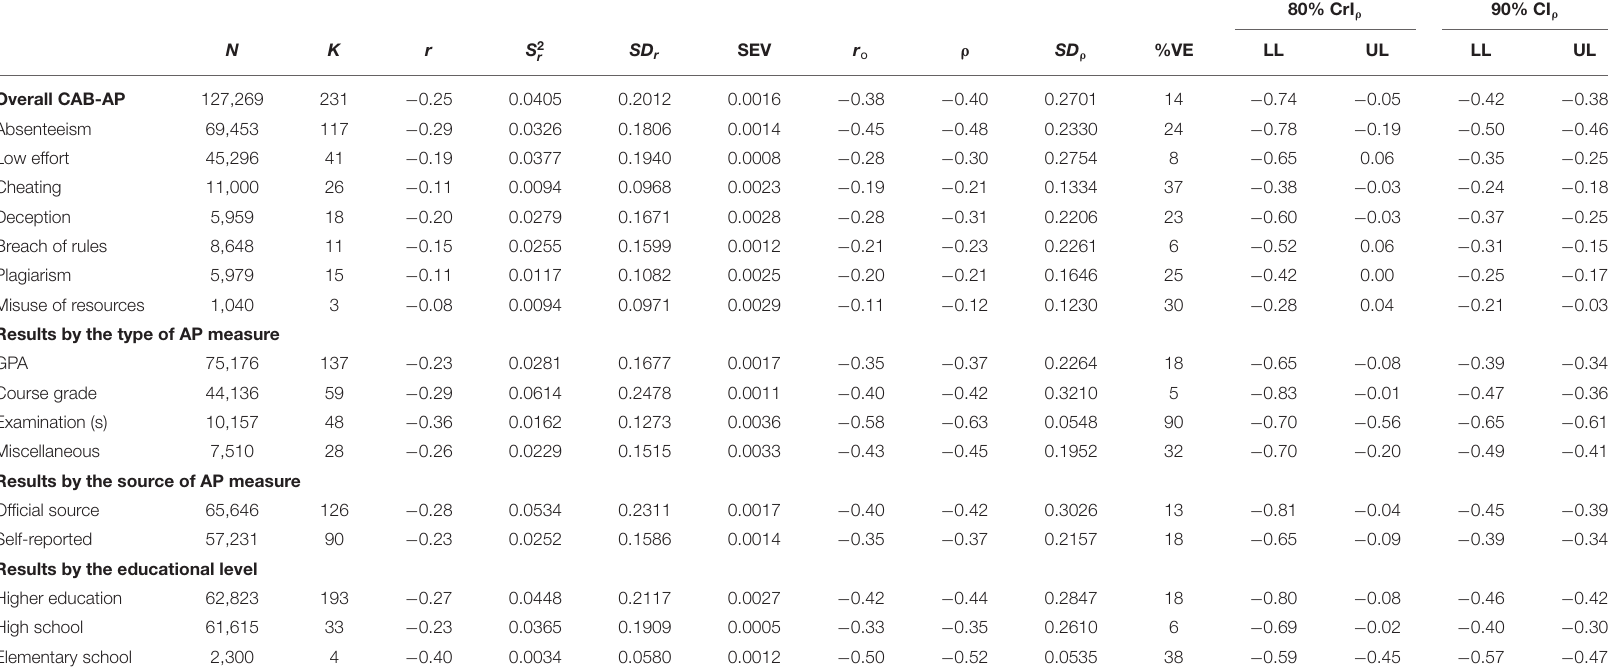
TABLE 2 | Meta-analyses of the combination of overall CAB, its facets, and